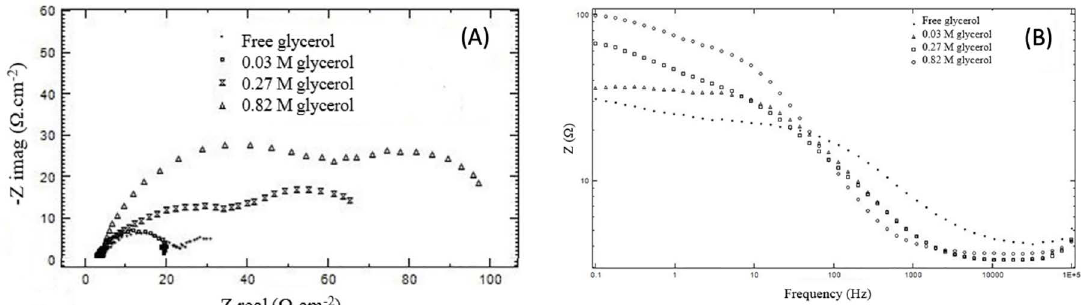
Figure 11. EIS analysis of the Zn electrodeposit in 0.5 M NaCl, (A) without and (B) in the presence of